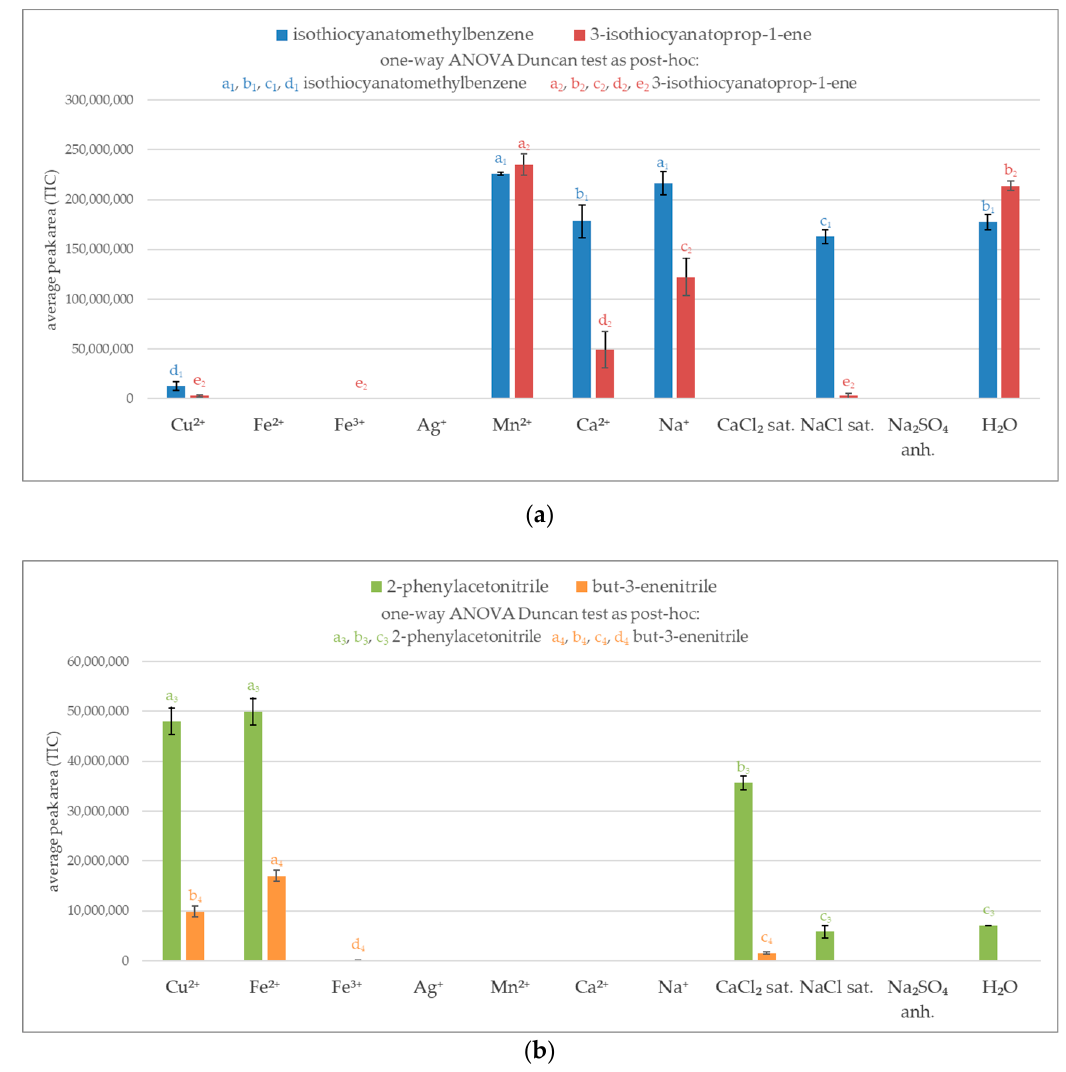
Figure 1. Volatile products of glucosinolates breakdown in miscellaneous enzyme inactivation media; sat.—saturated solution; anh.—anhydrous; a, b, c, d, e —the result of statistical analysis (one-way ANOVA Duncan test as post-hoc), values followed by the same letter in a Duncan grouping are not significantly different, the subscript number and letter color are corresponding to the chart legend ( α = 0.05); (n = 3); ( a ) Isothiocyanates (isothiocyanatomethylbenzene derived from glucotropaeolin and 3-isothiocyanatoprop-1-ene is a product from sinigrin); ( b ) Nitriles (2-phenylacetonitrile from glucotropaeolin and but-3-enenitrile from sinigrin).